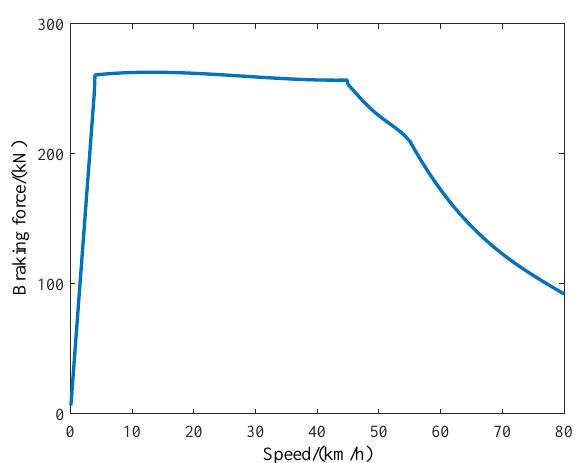
Figure 5. Electric braking force curve of urban rail